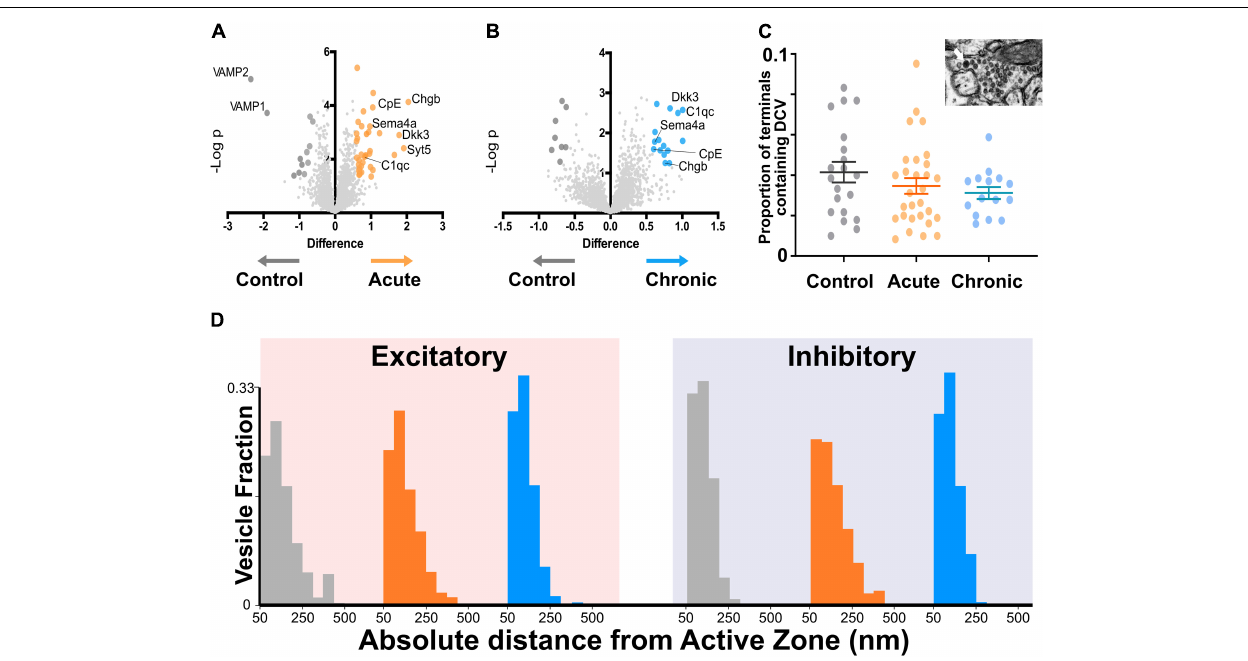
FIGURE 3 | Proteomics analysis of synaptosomes reveal an increase of proteins involved in vesicular positioning. (A,B) Differentially expressed proteins in Control vs. Acute (A) and Chronic epileptic phase (B) . Volcano plots are built plotting average ratio of TeNT vs. corresponding control against their t -test log P -values; significance thresholds: FDR > 0.05 and fold change > 0.6. Proteins significantly upregulated in Acute and Chronic tetanic animals are highlighted, respectively, in orange and light blue; proteins significantly downregulated are in dark gray. Proteins abbreviations are Dkk3, Dickkopf-related protein 3; Sema4a, Semaphorin 4A; Cpe, carboxypeptidase e; Chgb, chromogranin b; Syt5, synaptotagmin5; VAMP1, Vesicle-associated membrane protein 1; VAMP2, Vesicle-associated membrane protein 2; C1qc, Complement C1q C Chain. (C) Proportion of presynaptic terminals containing Dense Core Vesicles in different non-overlapping sampled areas